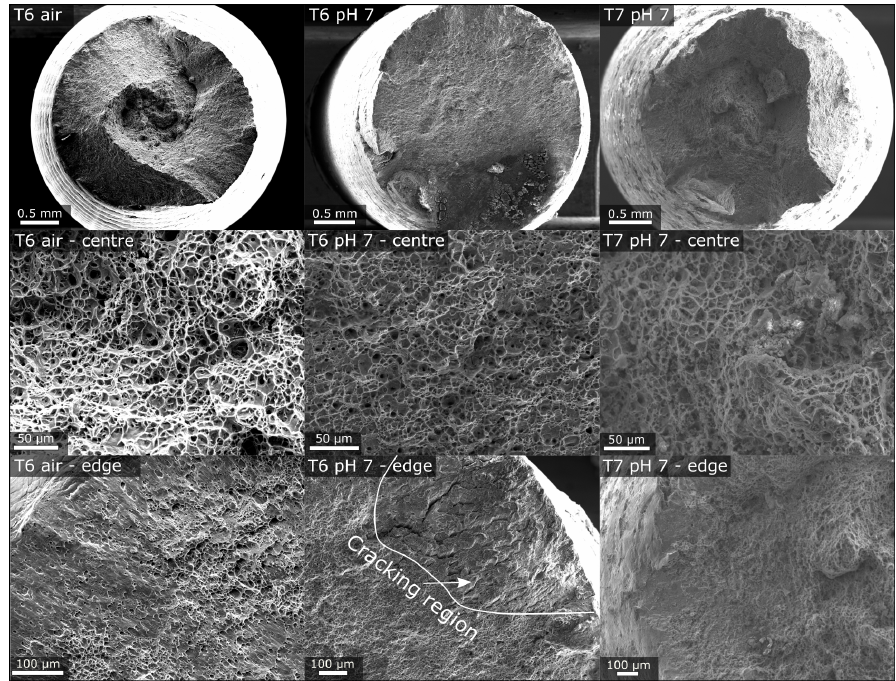
Figure 14. Fracture surfaces of selected samples in air and in solution, with highlighted features in the centre and close to the edge. The main difference is the cracking behaviour observed in the T6 tempers when testing in solution, as highlighted for T6 in pH